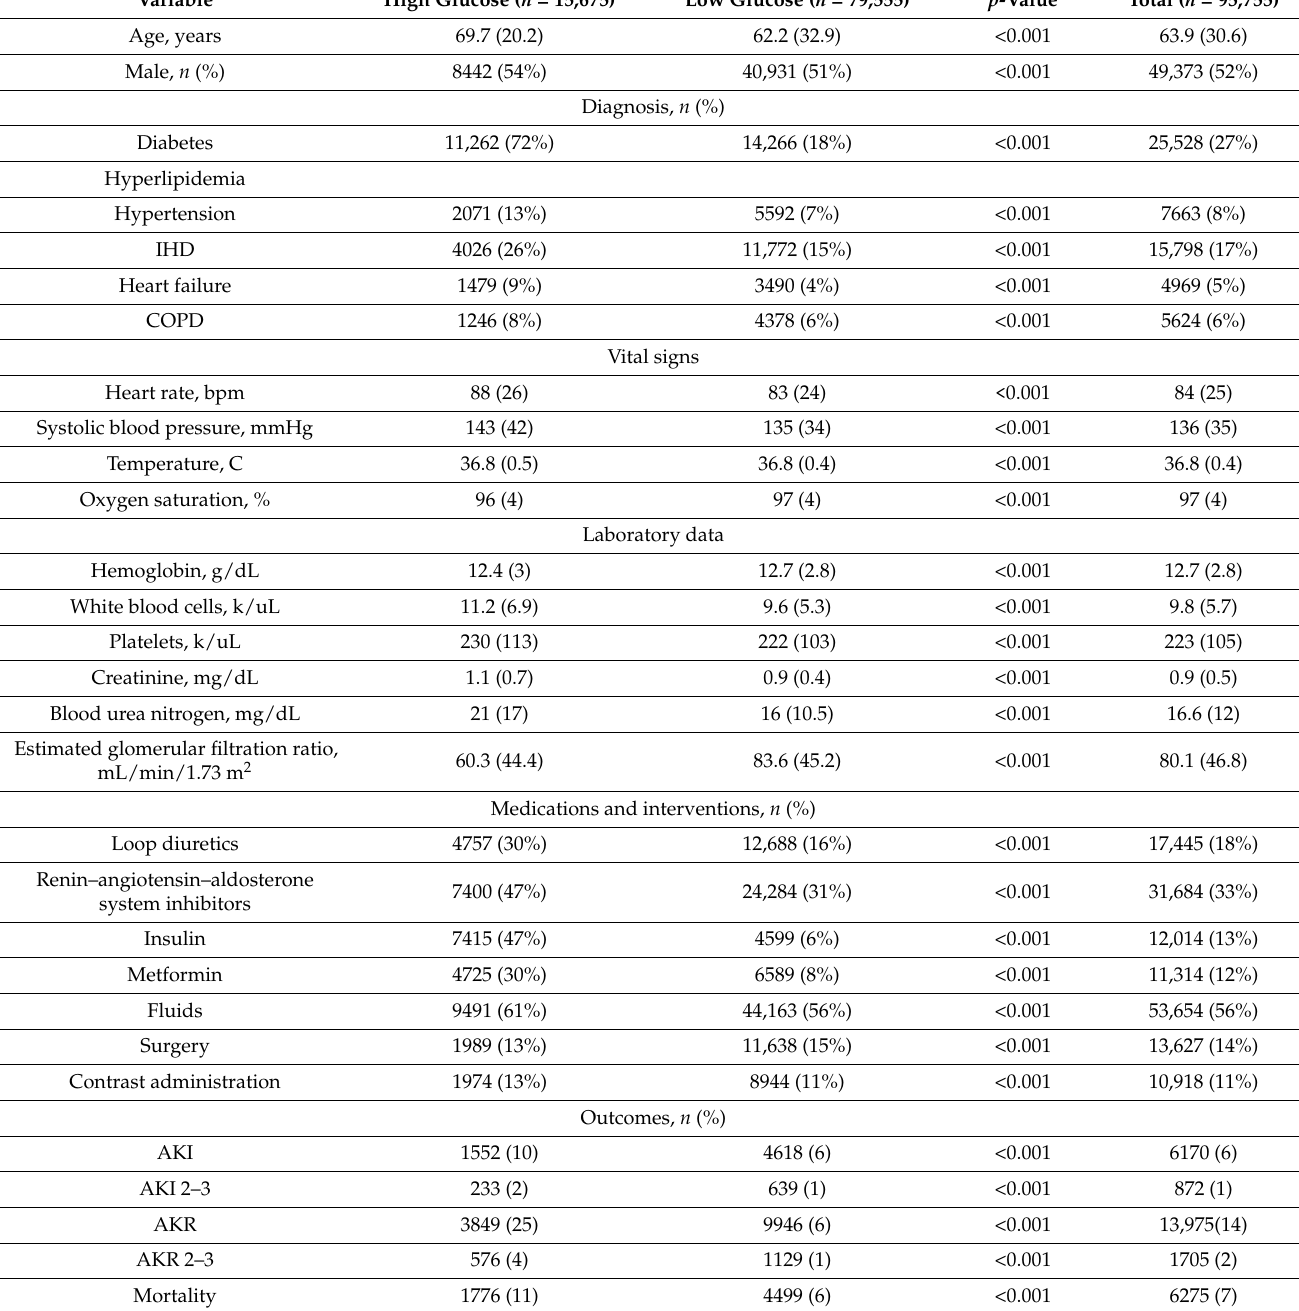
Table 1. Comparison of baseline variables, renal outcomes, and mortality between patients with high baseline serum glucose (>180 mg/dL) and lower-to-normal baseline serum glucose ( ≤ 180 mg/dL). Continuous variables are presented as medians with interquartile ranges. Categorical variables are presented as absolute numbers and